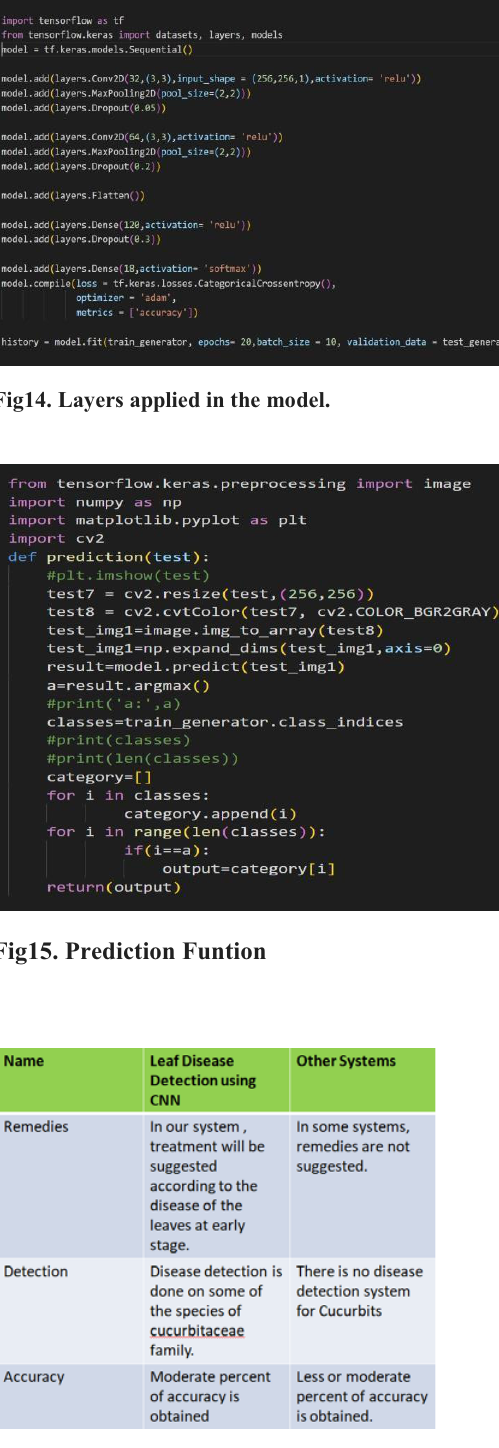
Table 1 Comparison of our system with other existing